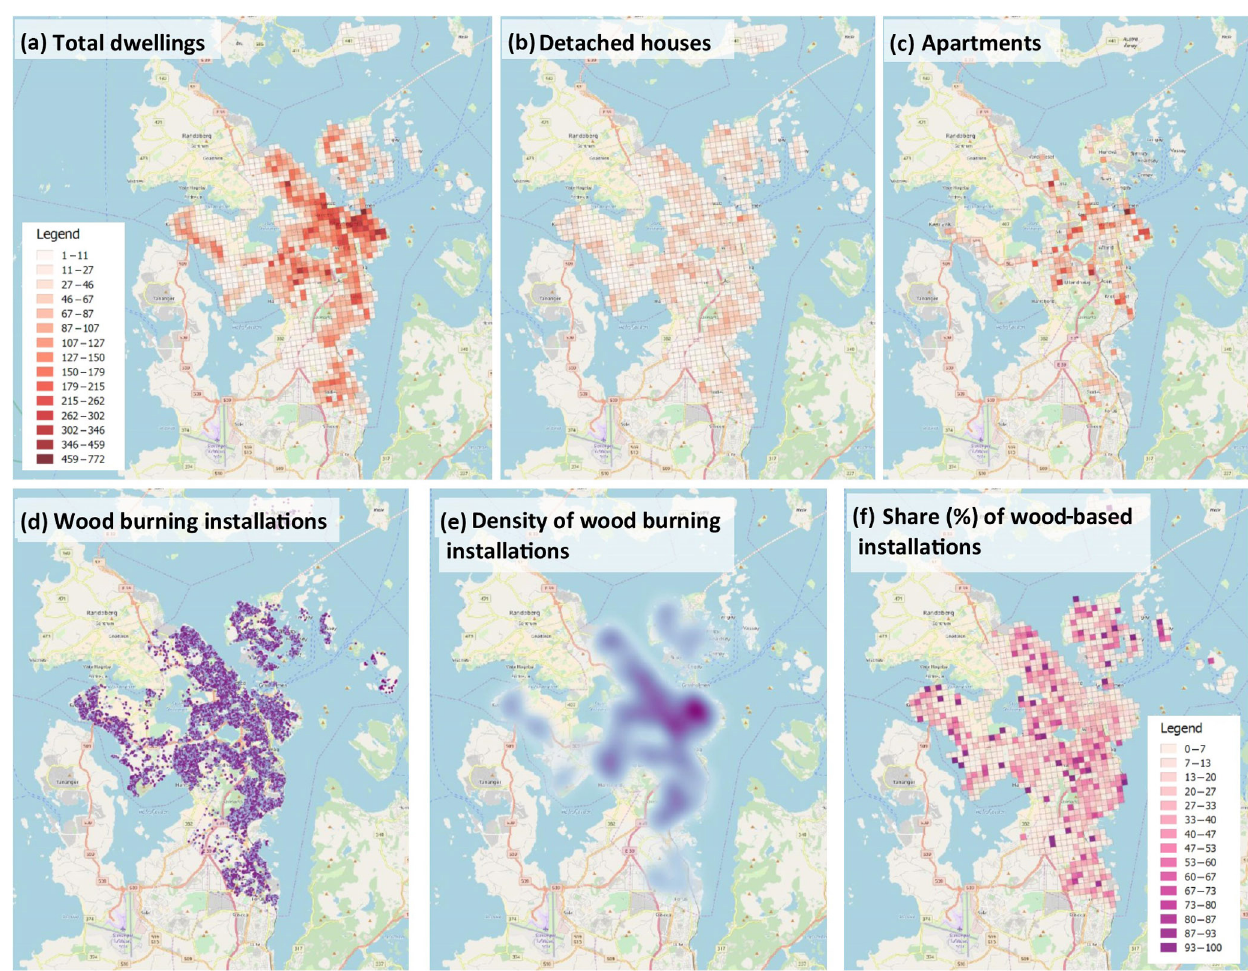
Figure 2. Example of part of the input data used in the MetVed model in the Municipality of Stavanger. (a) Total dwelling number at 250m grid resolution. (b) Number of detached hours. (c) Number of apartments. (d) Individual wood burning installations from the fire and rescue agency. (e) Density of wood burning installations. (f) Share (%) of wood-based installations for residential heating obtained from the web-crawled data set. Background map: © OpenStreetMap contributors 2019. Distributed under a Creative Commons BY-SA